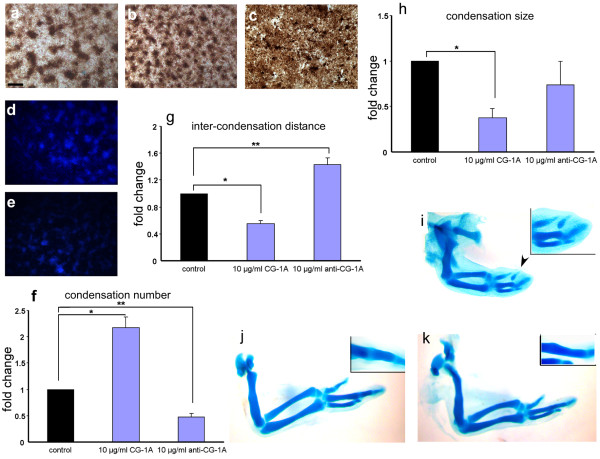
Addition of CG-1A increases condensation number and density in vitro and induces ectopic cartilage in vivo. (a) PNA staining of a 2-day control leg culture. (b) Addition of 10 μg/ml CG-1A increases the condensation number, with a concomitant decrease in size. (c) Treatment with 20 μg/ml CG-1A causes the condensations to fuse. (d) Untreated control 2-day micromass culture fixed and stained with DAPI. (e) Culture treated with 10 μg/ml anti-CG-1A antibody, fixed at day 2, and stained with DAPI. Photomicrographs (a-e) are at same level of magnification; bar in (a) represents 0.25 mm. (f) Graph showing change in condensation number upon addition of 10 μg/ml CG-1A and 10 μg/ml anti-CG-1A antibody, respectively. (g) Graph showing change in inter-condensation distance upon addition of 10 μg/ml CG-1A and 10 μg/ml anti-CG-1A antibody, respectively. (h) Graph showing change in condensation size upon addition of 10 μg/ml CG-1A and 10 μg/ml anti-CG-1A antibody, respectively. All three variables (condensation number, size and inter-condensation distance) were statistically analyzed using one-way analysis of variance comparing means by the Tukey-Kramer post-hoc analysis. Results are shown as means ± S.E.M. (* p < 0.05). (i) 5½ day wing bud injected on with CG-1A, fixed and stained with Alcian blue on day 8, shows the presence of an ectopic digit in the site of injection (black arrowhead). Inset of i shows the ectopic digit in detail. (j) Untreated 8½ day control wing stained with Alcian blue showing three digits; with discernible patency of joint space between the second digit phalange and 1st metacarpal in the inset of (j). (k) Contralateral wing bud of (j), injected with CG-1A on the 5th day, fixed and stained with Alcian blue showing fusion of the phalange and 1st metacarpal of the second digit and obliteration of their joint space (inset of k).